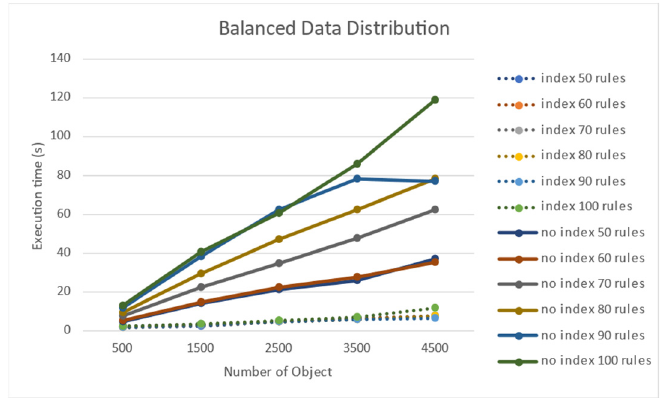
Figure 11. Performance effect of the number of objects on a uniform object distribution.